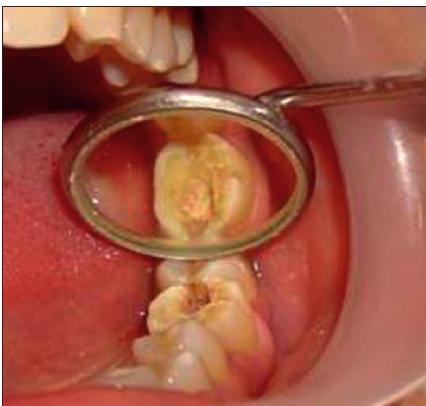
Figure 3: CAD/CAM image.